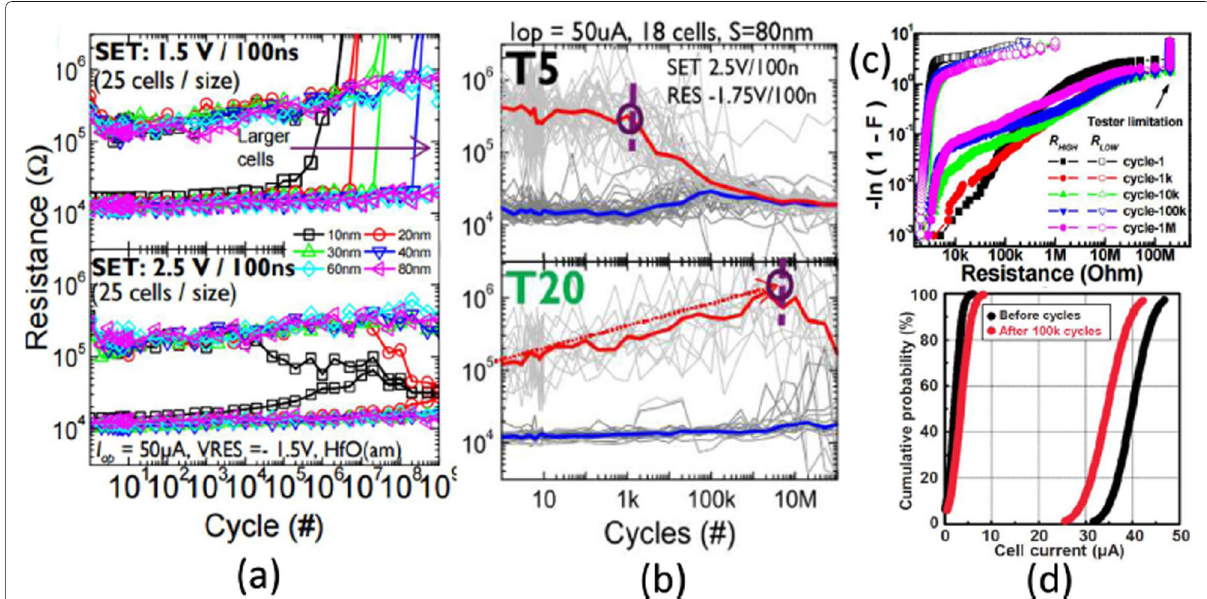
Fig. 6 a Endurance cycles of HfO x -based RRAM at different SET voltage and cell size b with different thickness (T5= 2 nm, T20= 10 nm) at 2.5 V set voltage. c Resistance distribution of 1-kb array obtained from Weibull plots under different endurance cycles. d 100 k cycles endurance of 2-Mb-Ta 2 O 5 -based array; Reprinted from refs